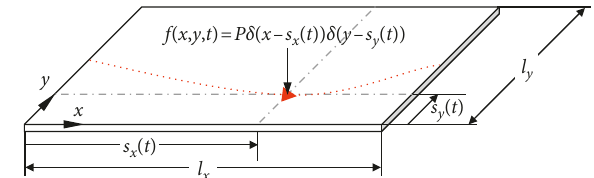
Figure 1: A thin rectangular plate subjected to a moving point force P , where the red arrow indicates current position of the moving point